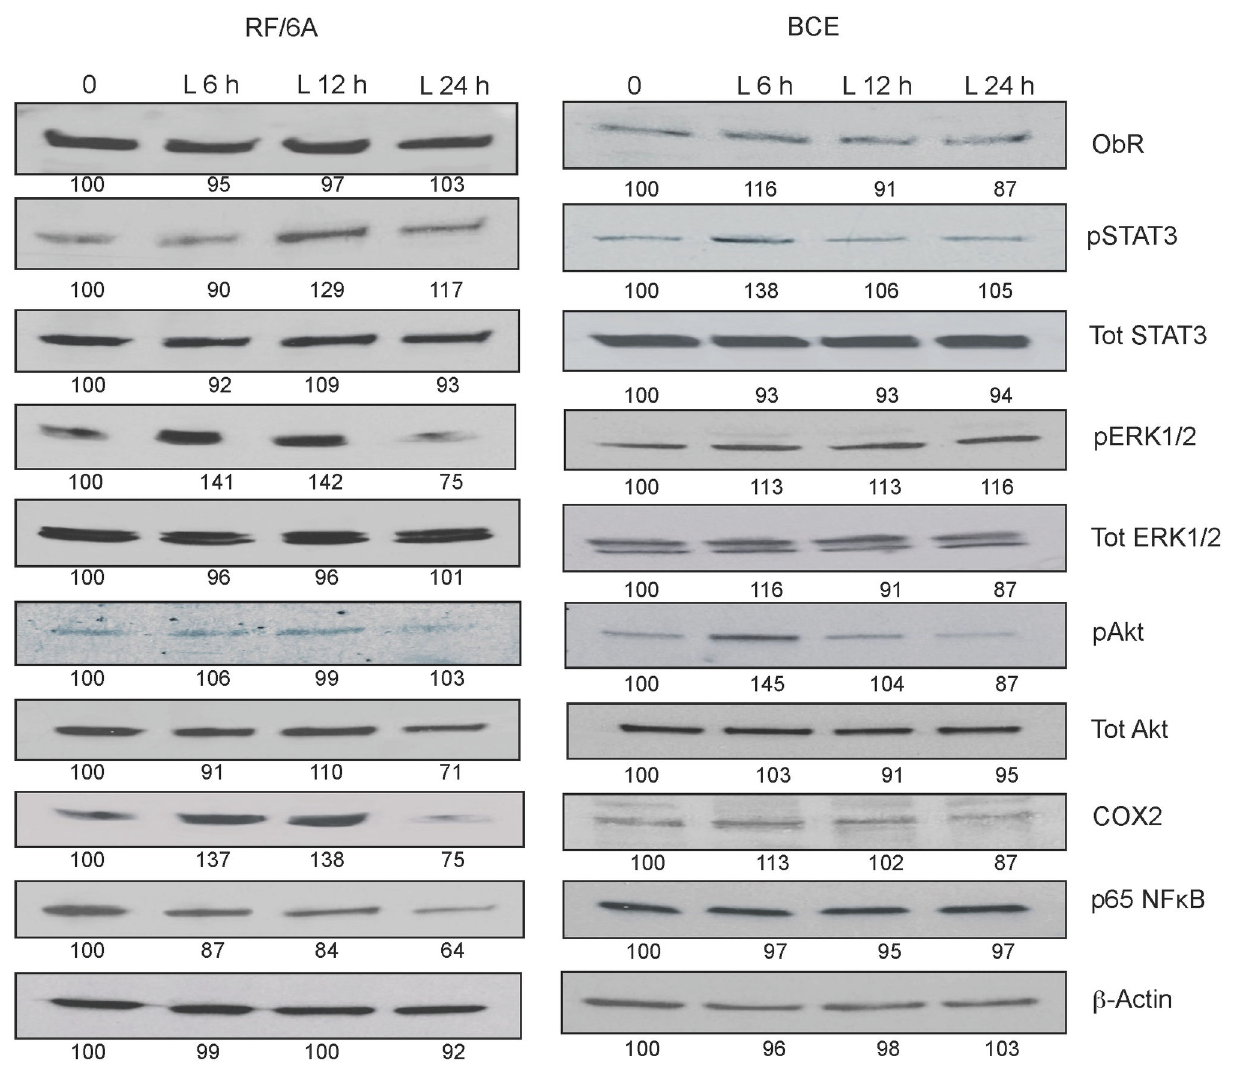
Figure 6. Long-term intracellular leptin effects in RF/6A and BCE cells. RF/6A and BCE cells were stimulated with 250 ng/mL leptin (L) for 6, 12, 24 h as described in Materials and Methods. The numbers under WB panels represent relative densitometry values (%) of phosphorylated and total proteins, with the value in SFM is taken as 100%. The representative blots of at least 3 experiments are shown.